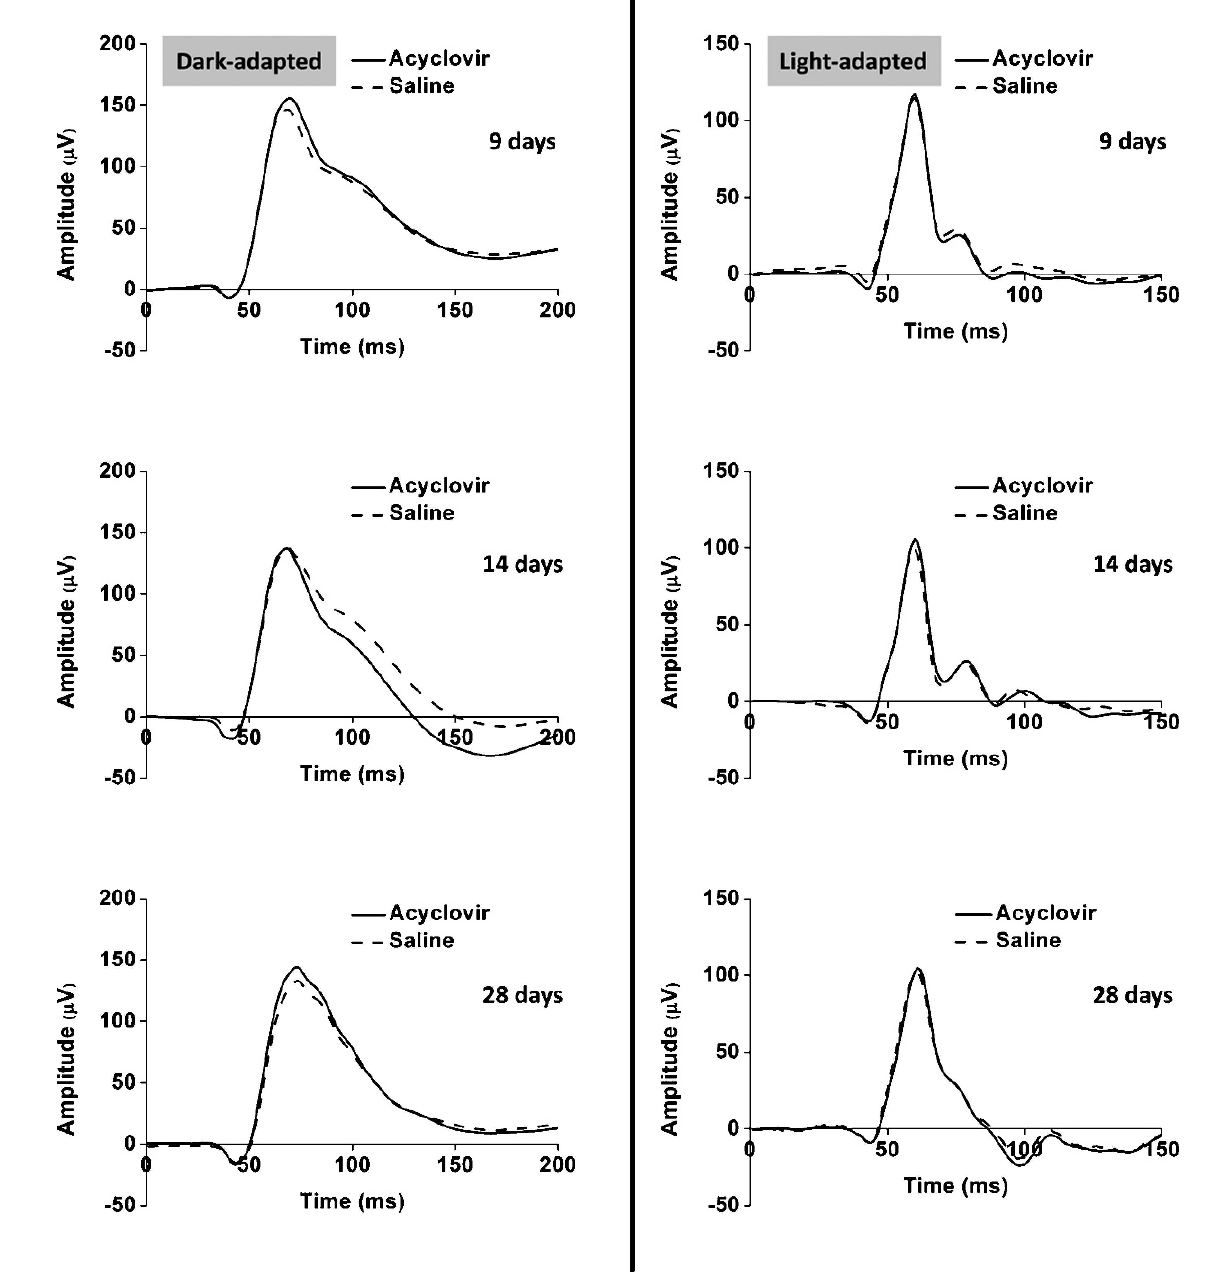
Figure 2 - Representative ERG recordings of the eyes of one animal at different time points [dark-adapted (30 cd.s/m 2 ) and light- adapted (3 cd.s/m 2